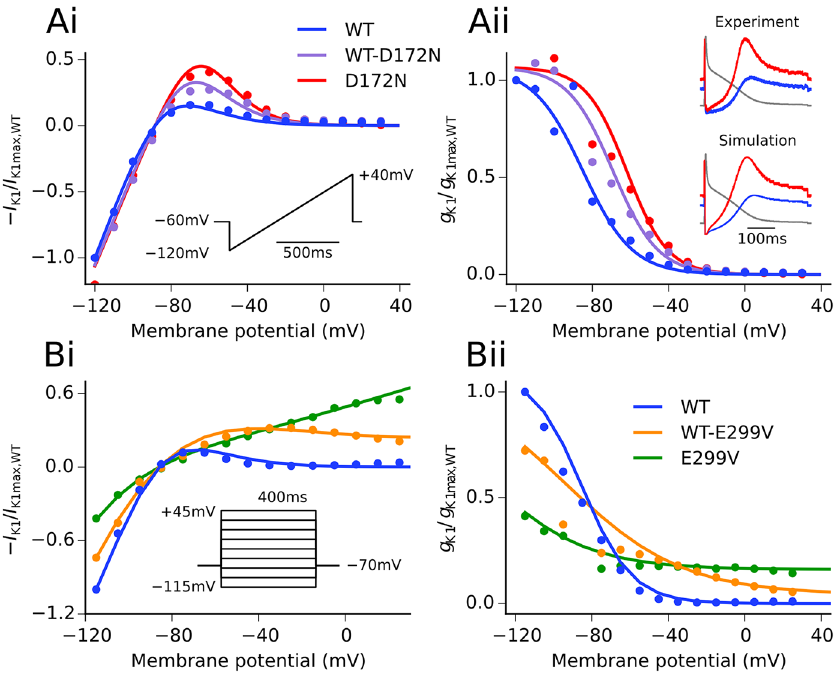
Fig 1. Experimental and simulated I-V and g K1 -V relationships. Comparison of model I-V relationship (Ai) and computed g K1 -V relationship (Aii) in WT, WT-D172N, and D172N conditions (solid lines) with the experimental data of El Harchi et al . [26] (points). Simulated AP clamps using a digitisedAP waveform from the Nygren et al . human atrial cell model [30] as describedin [26] are shown inset. Comparisonof model I-V relationship (Bi) and computed g K1 -V relationship(Bii) in WT, WT-E299V, and E299V conditions(solid lines) with the experimental data of Deo et al . [6] (points). The voltageclamp protocol used in each case is shown inset in